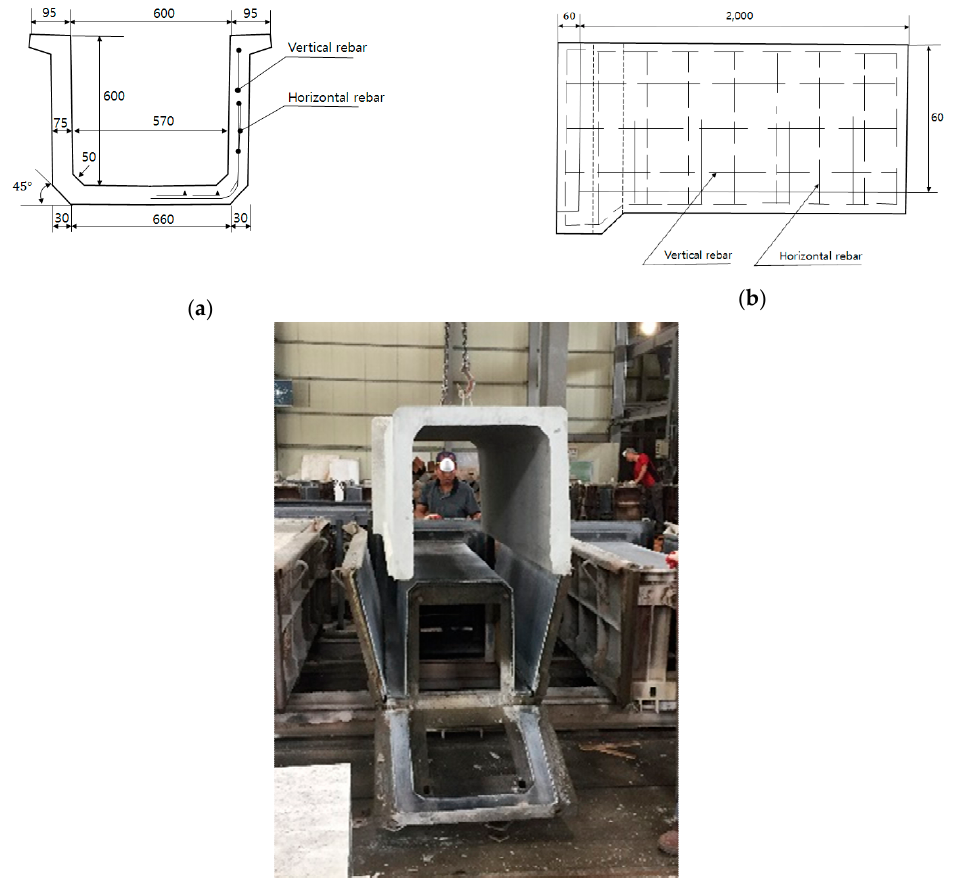
Figure 2. Dimensions and type of LWGP concrete flumes. ( a ) Cross section; ( b ) Longitudinal section; ( c ) Specimens production.